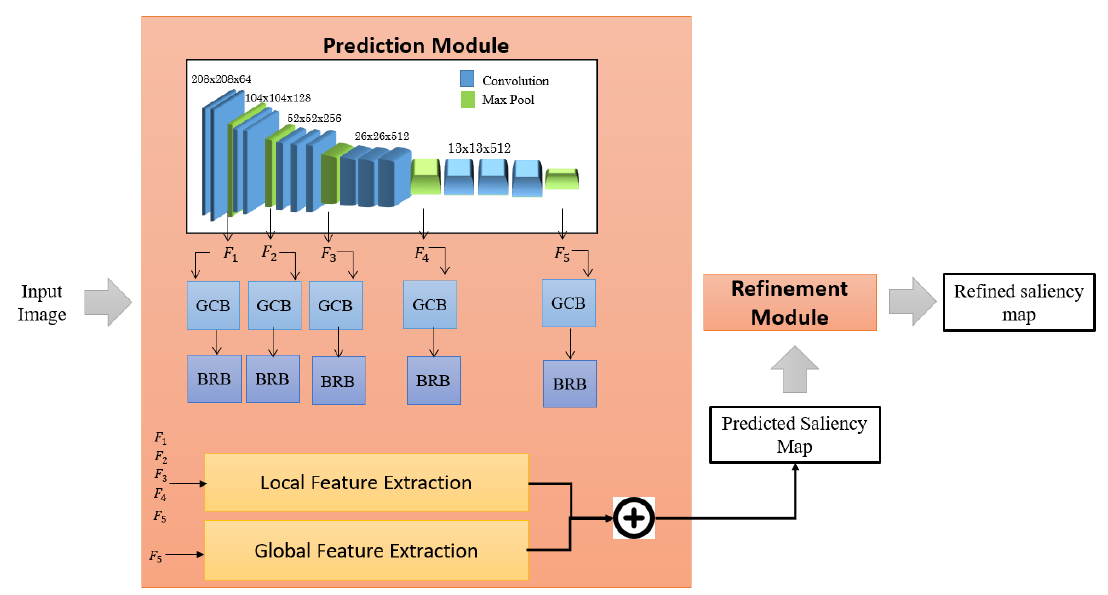
Figure 1. Overview of proposed model (SODL), which consists of prediction module and refinement module. Image is passed to prediction module that learns deep features and produces a predicted saliency map, which is refined by the refinement module. This refined saliency map is taken as the final